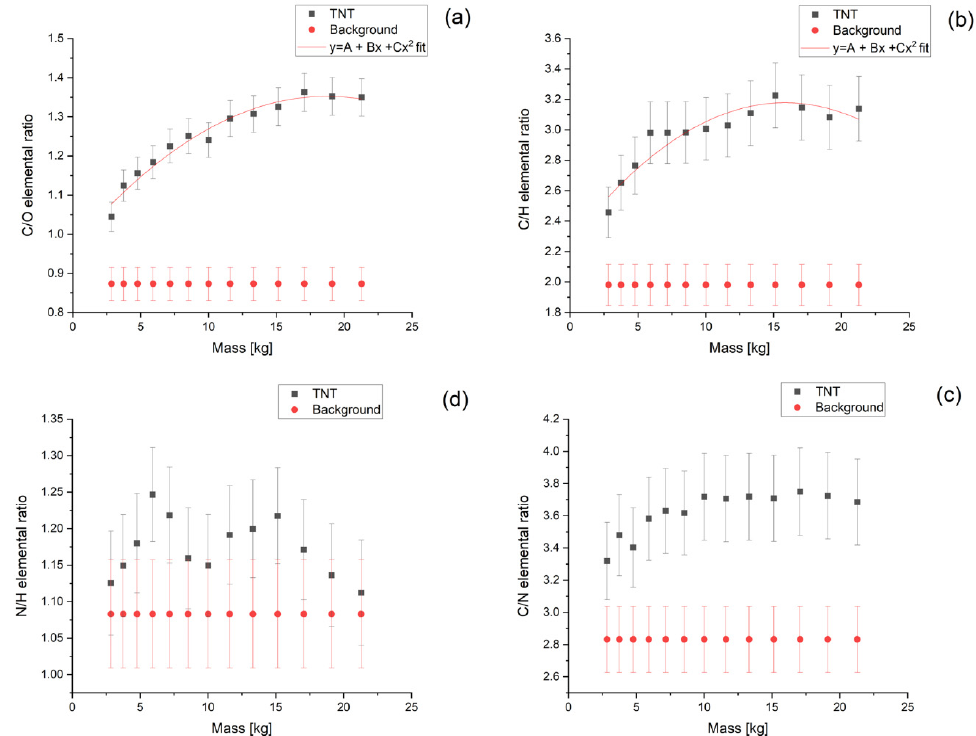
Figure 8. Elemental ratios of carbon and oxygen ( a ), carbon and hydrogen ( b ), carbon and nitrogen ( c ) and nitrogen and hydrogen ( d ), obtained for simulations performed for different masses of TNT with the γ -ray detector 2cm above the sample. The C/O and C/H ratios were fitted with a parabola function with parameter values equal to ( a ) A = 0.969 ± 0.021, B = 0.041 ± 0.005, C = 0.0011 ± 0.0002; ( b ) A = 2.262 ± 0.087, B = 0.116 ± 0.018, C = − 0.0037 ± 0.0008.